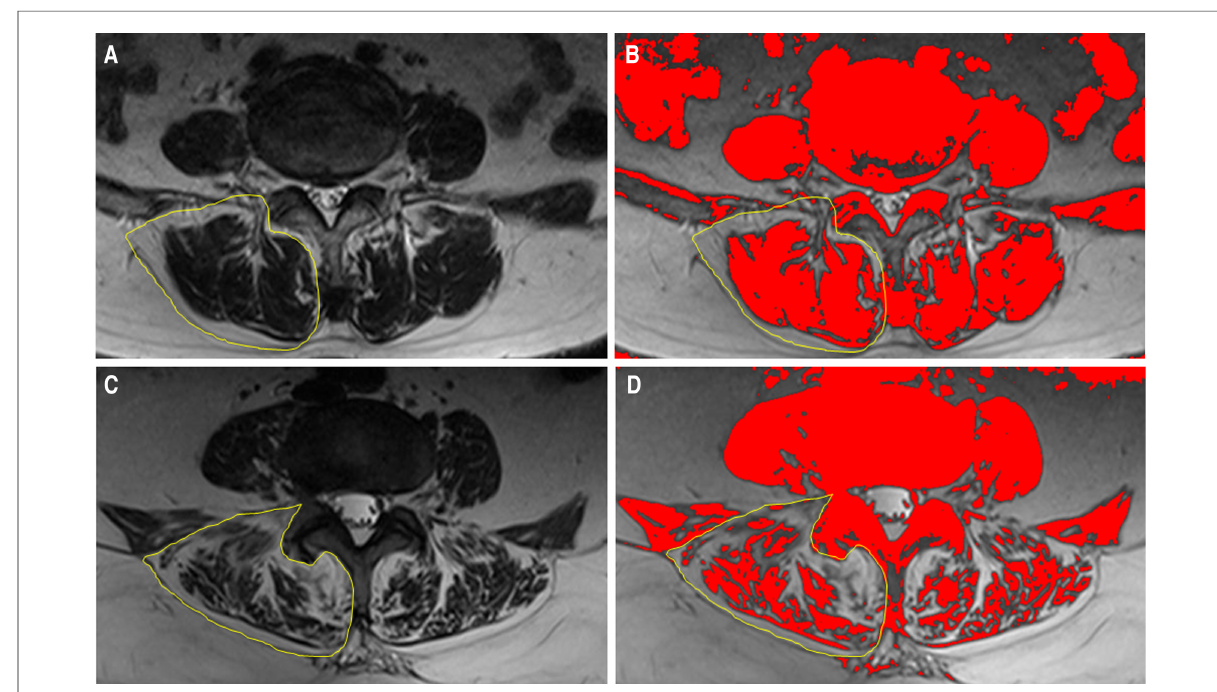
FIGURE 6 Illustration of the comparison between patients who underwent reoperation after PTED and controls. The circled area indicates the unilateral paraspinal muscle. ( A,B )Preoperative paraspinal muscle mass of a 62-year-old woman in the control group. ( C,D )Preoperative paraspinal muscle mass of a 65-year-old woman in the reoperation